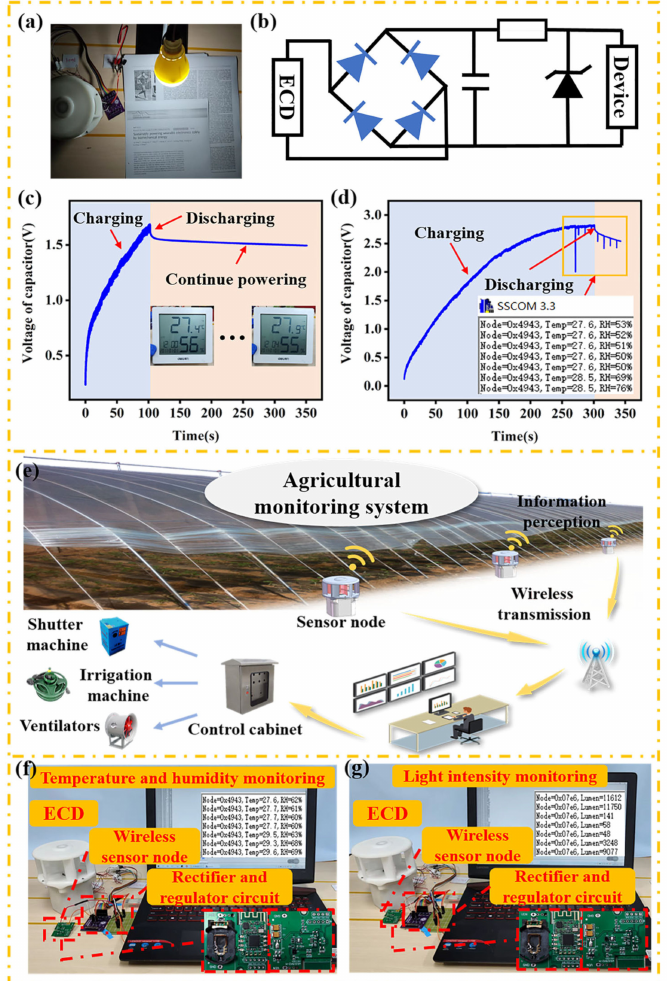
Figure 9. Schematic diagram of ECD application: ( a ) the energy-saving bulb powered by ECD; ( b ) the power management circuit of ECD; ( c ) charging and discharging processes of a 6 mF capacitor to power the temperature/humidity device; ( d ) charging and discharging processes of a 6 mF capacitor to power the temperature/humidity sensor node; ( e ) schematic diagram of the agricultural monitoring system; ( f ) scene diagram of the temperature and humidity monitoring; ( g ) scene diagram of the light intensity